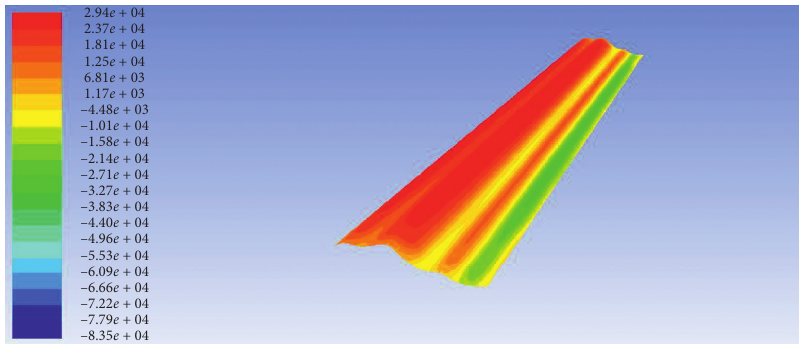
Figure 13: Pressure of the lower surface of the airfoil.